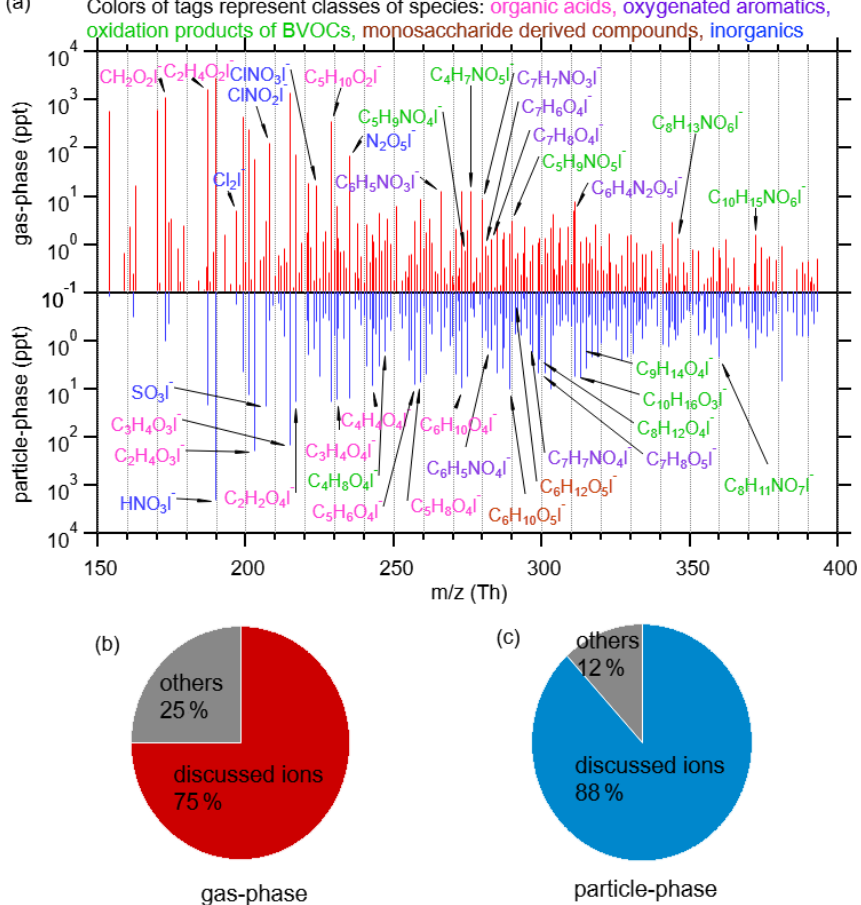
Figure 1. (a) Mass spectra of the iodide charged ion within m/z 150–400Th in the gas phase (red) and the particle phase (blue), respectively. (b, c) The fractions of I-adduct ions discussed in the main text (Table 1) in the total ion signals for I-adduct ions measured in the gas phase (b) and the particle phase (c) ,